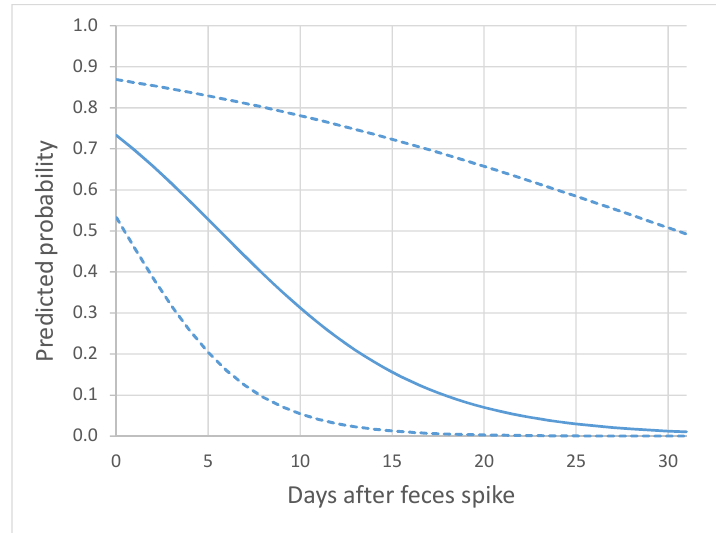
Figure 3. Predicted probability (mean (solid line) and 95% confidence interval (dashed line)) of detecting C. kirtlandii eDNA over time from the sediment of experimentally spiked artificial crayfish burrows. The binary logistic regression model was derived from the general estimating equation analysis, using days following spike as the single predictor of eDNA detection when two of three qPCR replicates was used as the threshold for detection (intercept = 1.012, β = −0.180).